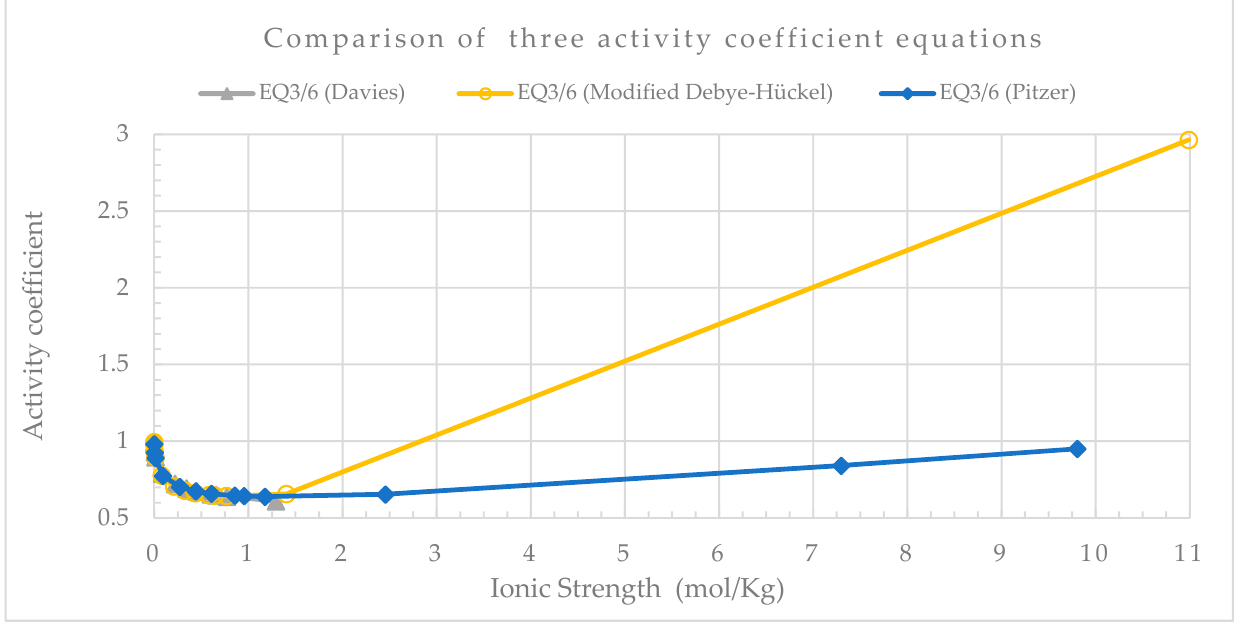
Figure 14. Dependence of the activity coefficient of Na + on the ionic strength for different activity coefficient equations through EQ3/6.